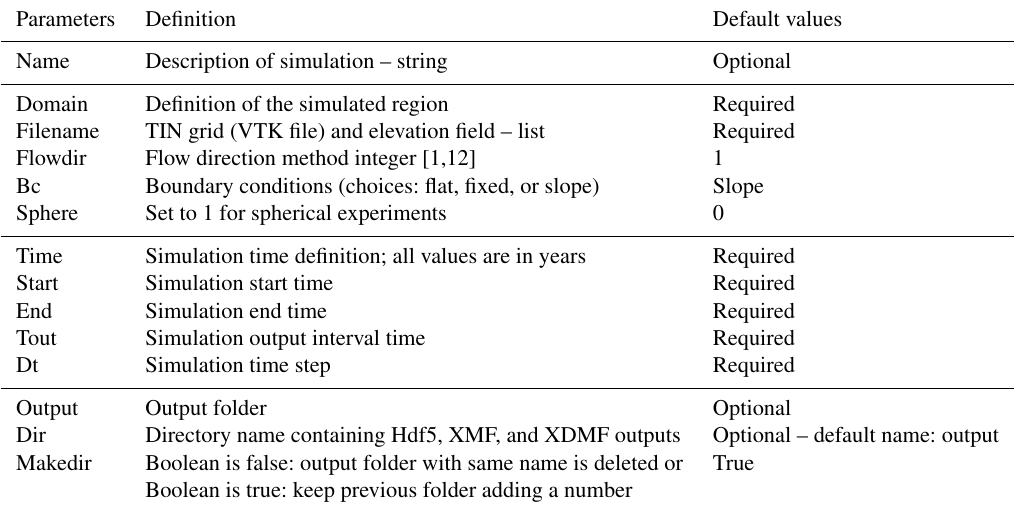
Table 1. Input parameters relative to initial surface, temporal extent, and output.